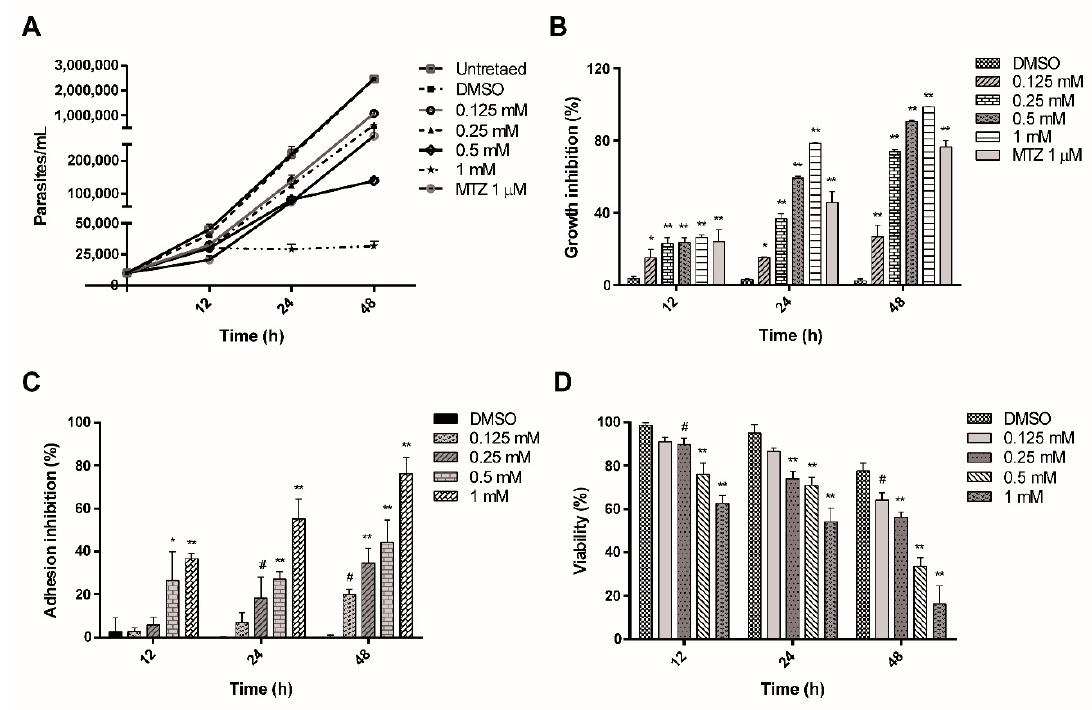
Table 1. Antigiardial, cytotoxicity and selectivity index values of acetylsalicylic acid (ASA).